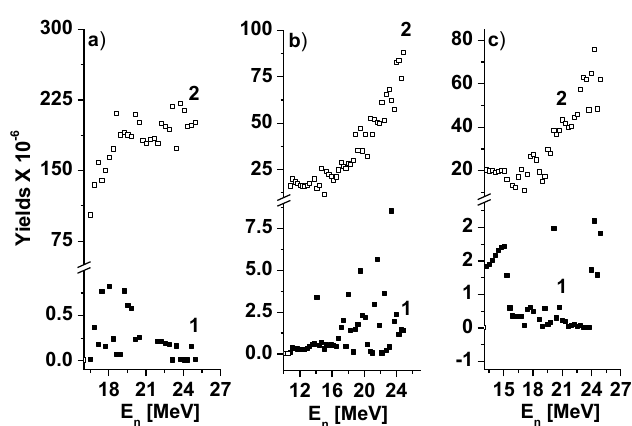
Fig. 4 . Relative yields isotope production as function of incident neutron energy: a) 99 Mo; b) 131 I; c) 133 Xe; Neutron emission: 1- Pre; 2- Post